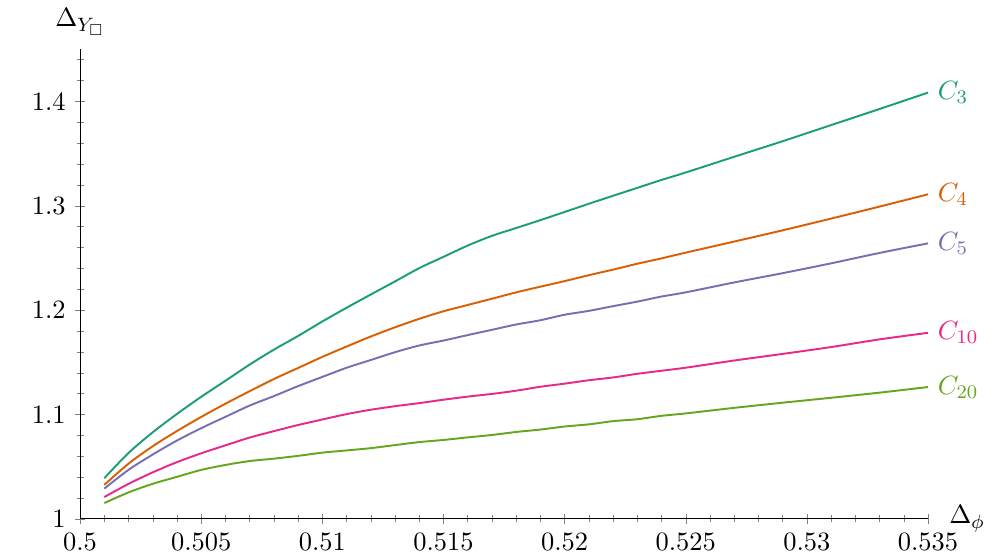
Figure 2 . Upper bound on the dimension of the (cid:12)rst scalar operator in the V + OPE as a function of the dimension of (cid:30) . Areas above the curves are excluded in the corresponding theories. The x-marker indicates the position of the decoupled Ising theory.